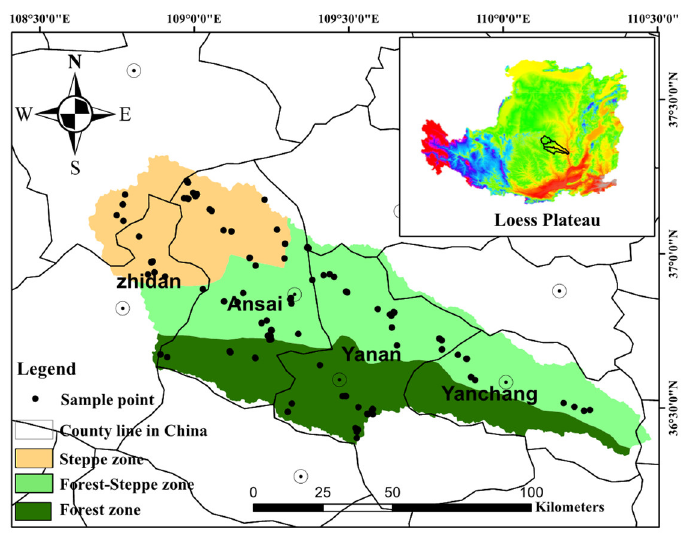
Figure 1. The locations in Yanhe River catchment in the Loess Plateau in China (CLP). Each dot is a sample plot, and a total of 145 observation plots were used to establish distribution models.